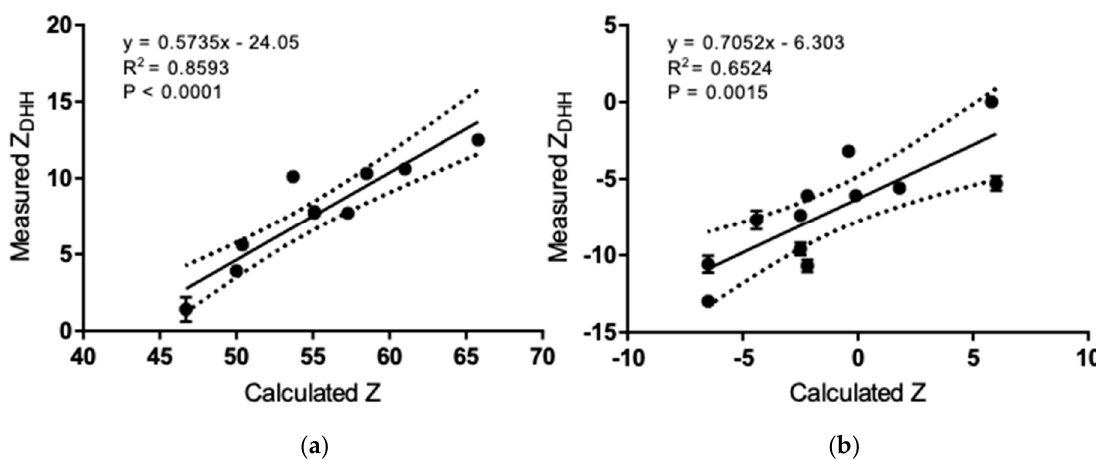
Figure 6. Linear regression analysis and correlation between experimental Z DHH measured by MCE and theoretical Z calculated from the IgG sequence. ( a ) pH 5.0 acetate. ( b ) pH 7.4 PBS. Dotted lines indicate the 95% confidence interval.